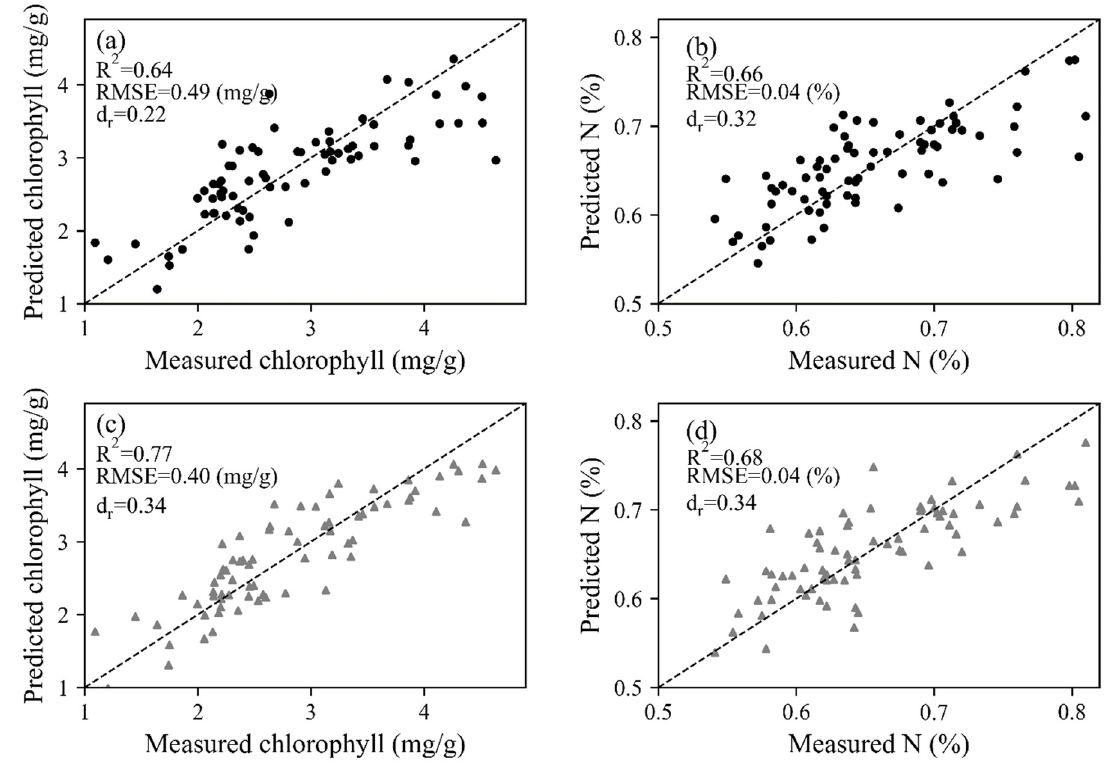
Figure 7. Leave-one-out cross-validation results of chlorophyll and N for ( a , b ) HSL and ( c , d ) ASD dataset. The dashed lines stand for 1:1 lines.